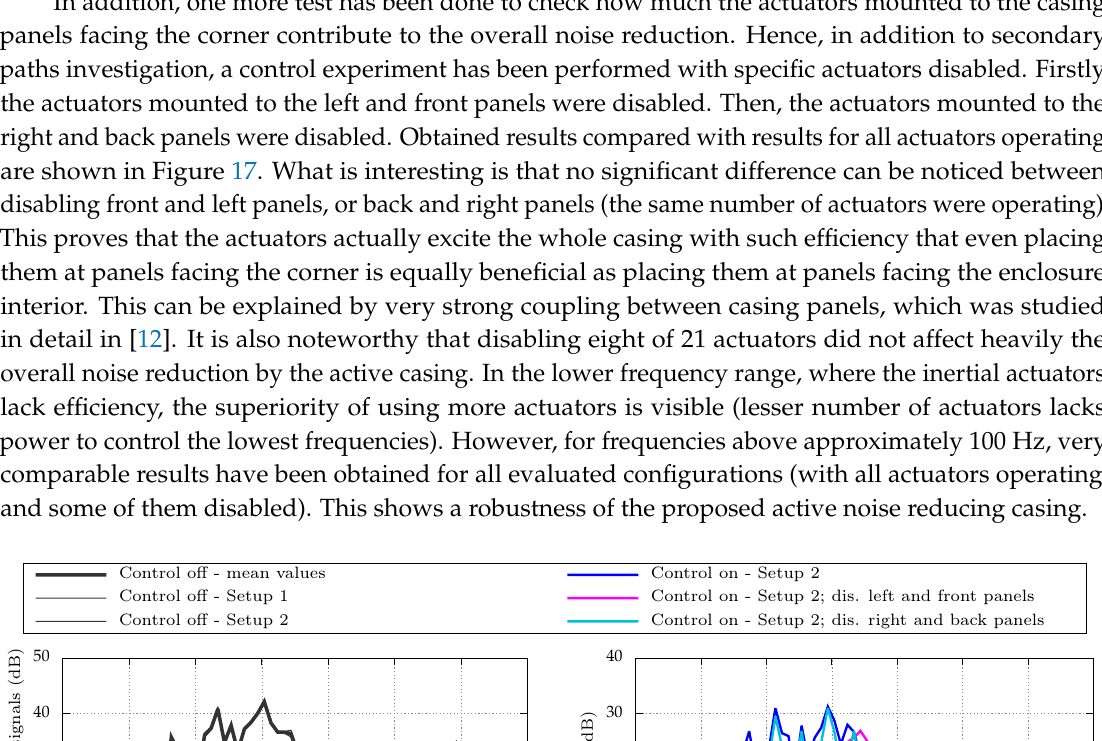
Control on - Setup 2 Control on - Setup 2; dis. left and front panels Control on - Setup 2; dis. right and back panels